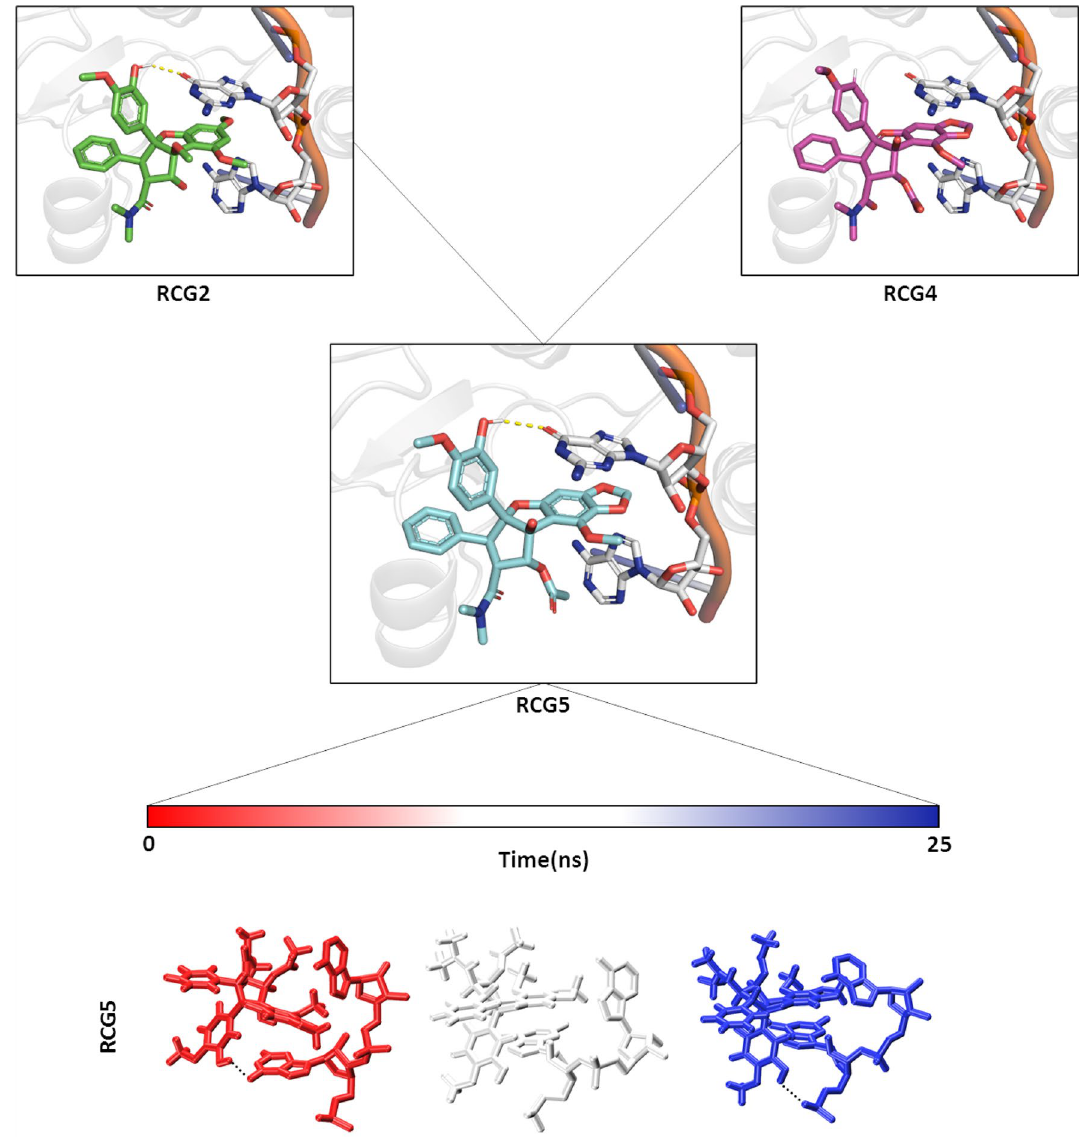
Figure 3. RCG2 is represented as green sticks, RCG4 as magenta sticks, RCG5 as pale-blue sticks. RNA bases involved in the interaction are represented as white sticks while the RNA backbone as orange cartoon. The yellow dashed lines represent the Hydrogen bond occurring between the R4 of both RCG5 and RCG2, and the RNA base. The time-step representation of the RCG5/RNA-bases trajectories is reported under the time bar. The black dashed lines represent both the starting Hydrogen bond and the final